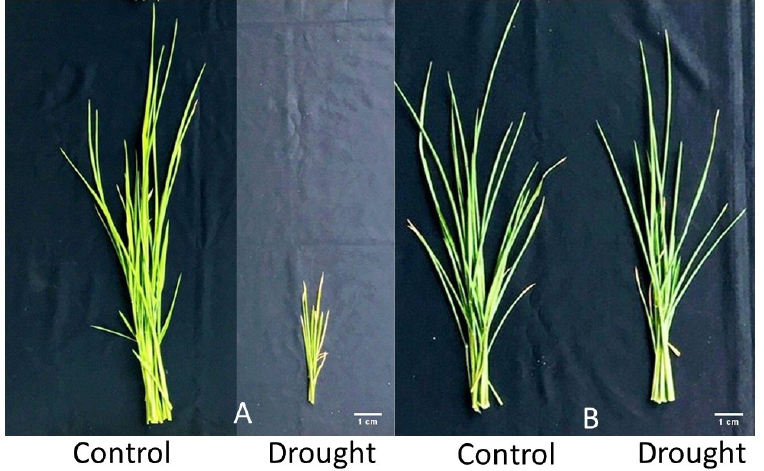
Figure 3. ( A ) Effect of drought on the biomass of drought-sensitive (IR49830) and ( B ) drought-tolerant (IR86635) rice genotypes showing maximum (2.06 g) and minimum (0.57 g) declines of the biomass observed 37 days after sowing. Scale bar = 1 cm.